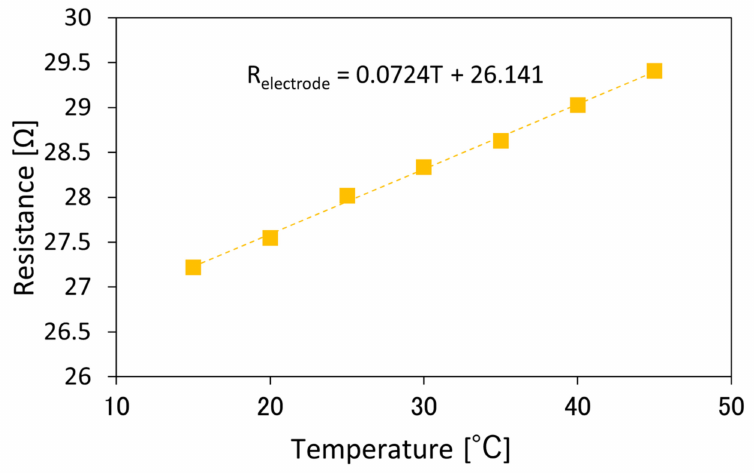
Figure 4. Temperature dependence of the resistance of the Co layer loaded on the Si waveguide ( w = 400 nm, and l = 8 µ m) without light